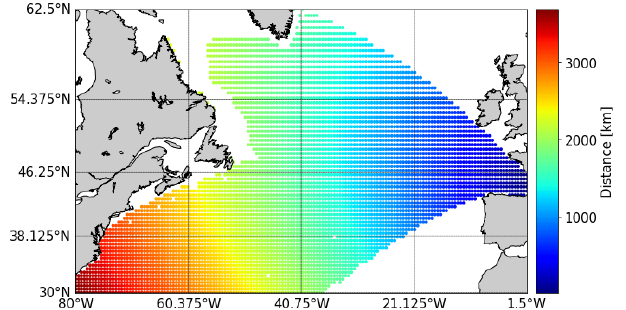
Figure 1. Distance to the point of